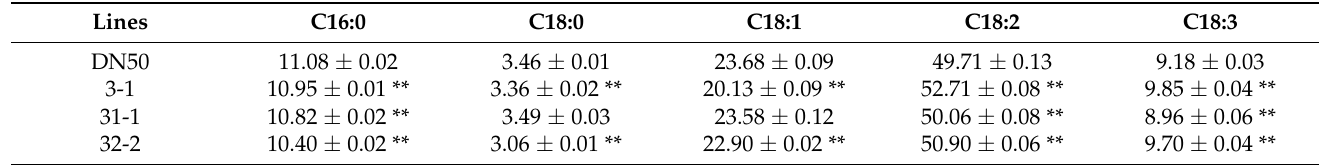
Table 1. Fatty acid composition of GmWRI1-OE lines and DN50.